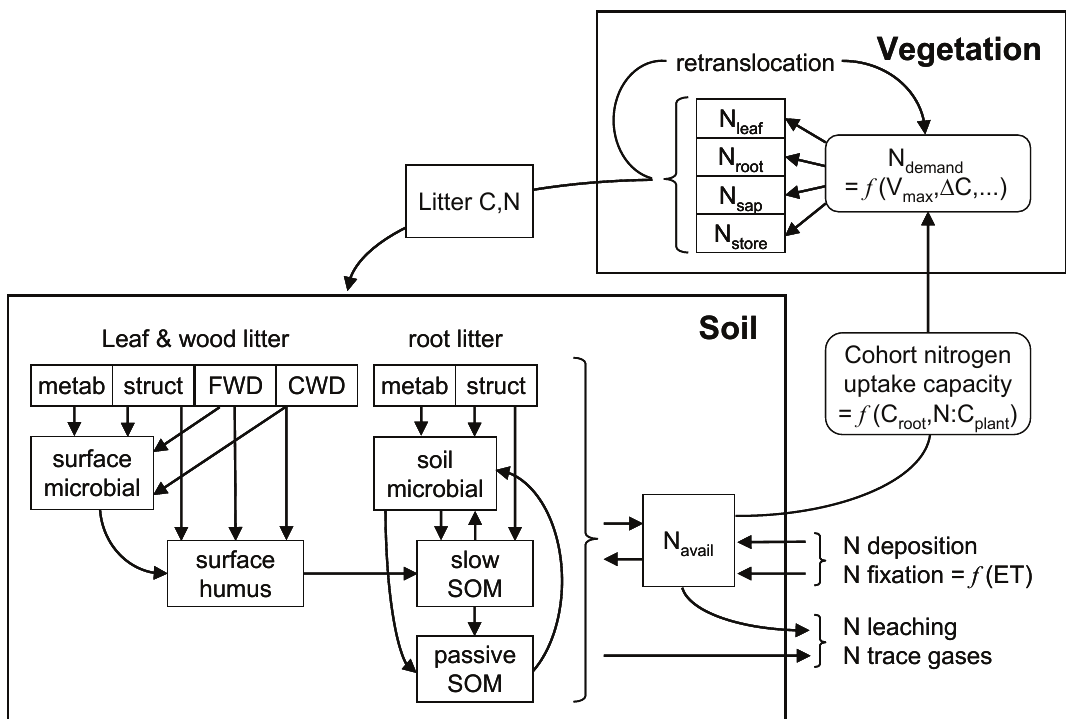
Fig. C1. Schematic overview of N cycle in LPJ-GUESS. Abbreviations: FWD=fine woody debris; CWD=coarse woody debris; N avail =soil mineral N pool; N leaf = leaf N mass; N root =fine root N mass; N sap =sapwood N mass; N store = plant labile N store; N demand =daily plant N demand; V max =canopy rubisco capacity; 1 C=daily biomass increment; N:C plant =aggregate N:C mass ratio for leaves and fine roots; ET=actual evapotranspiration. See text for further details.